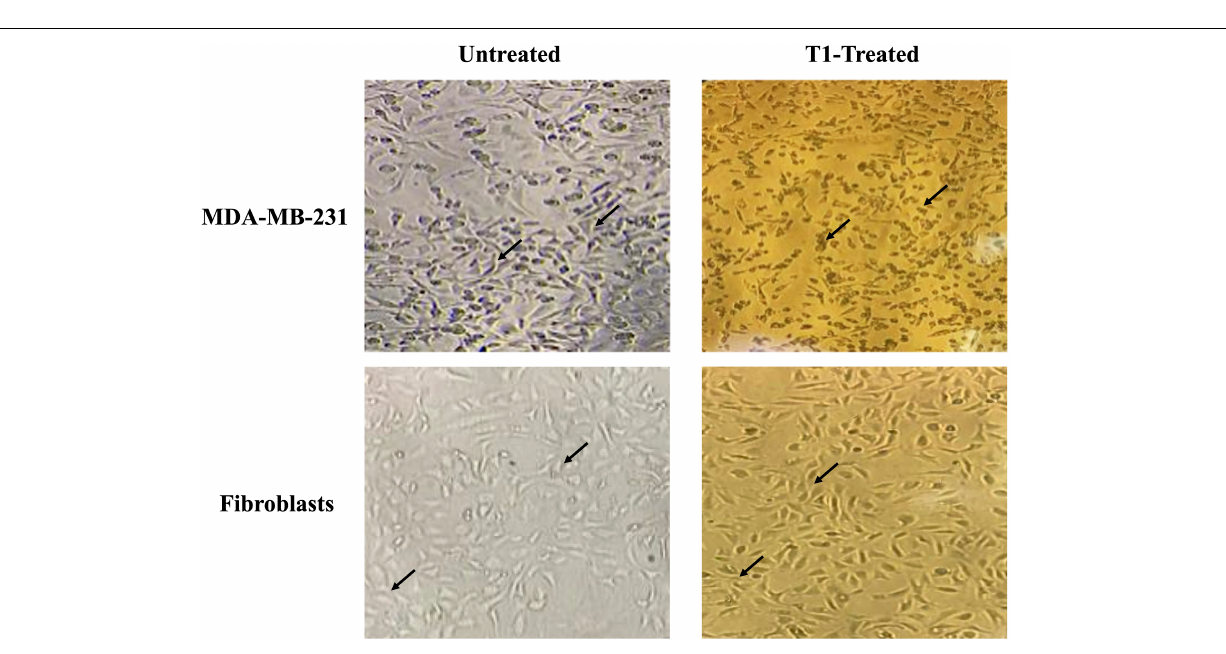
FIGURE 3 | Effect of T1-extract on the morphology of MDA-MB-231. T1 induced cell death and the formation of a monolayer of cells in the MDA-MB-231 cells (black arrows indicate loss of cell-cell adhesion), in comparison with untreated (control) and fibroblast cells, which show no cytotoxic effect, displaying a round phenotype and form multilayers; Black arrows indicate epithelial morphology with clear cell-cell